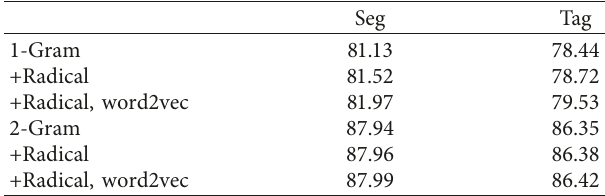
Table 3: F1 values on the development set using radical embed- dings and pretrained embeddings on BIGRU-CRF.